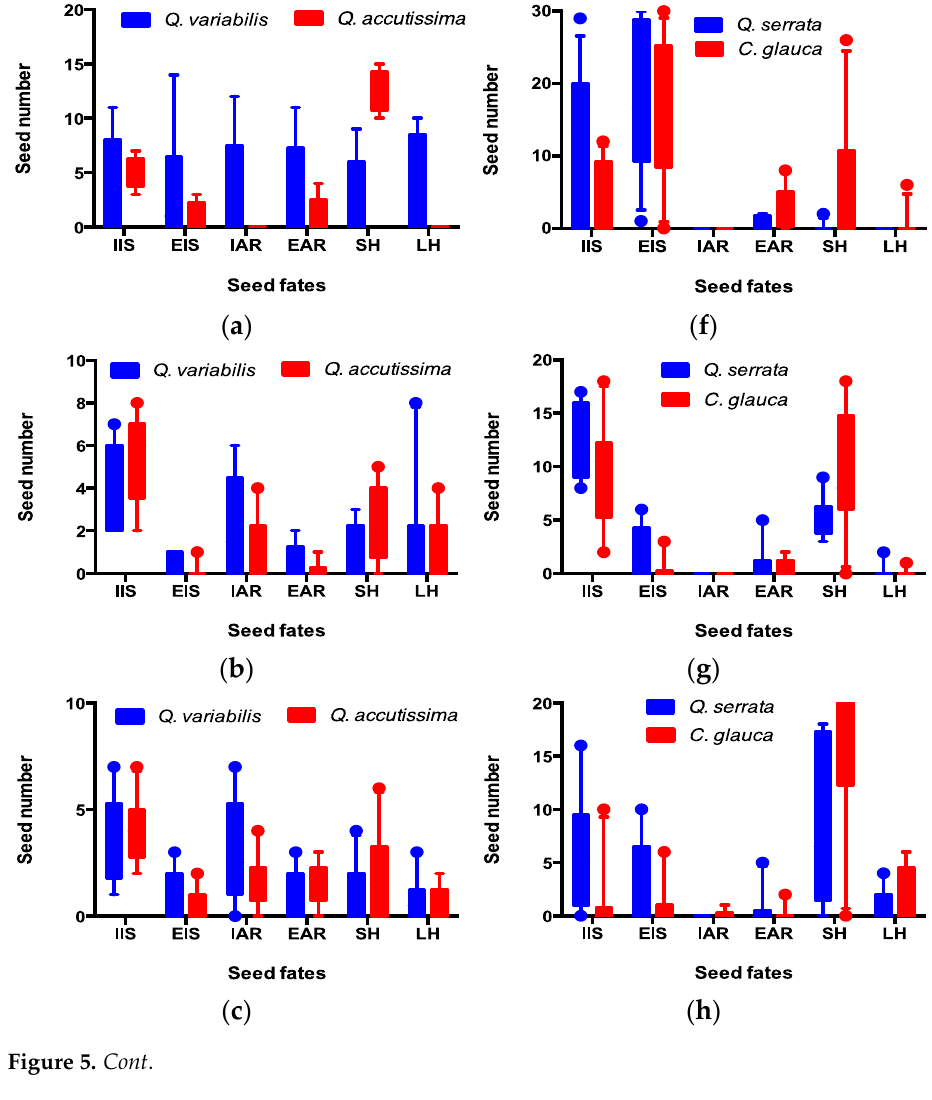
Figure 4. Seedling establishment from artificial caches of Q. variabilis , Q. accutissima , Q. serrata , and C. glauca . Bars sharing different letters indicate statistically significant at p < 0.05 level.